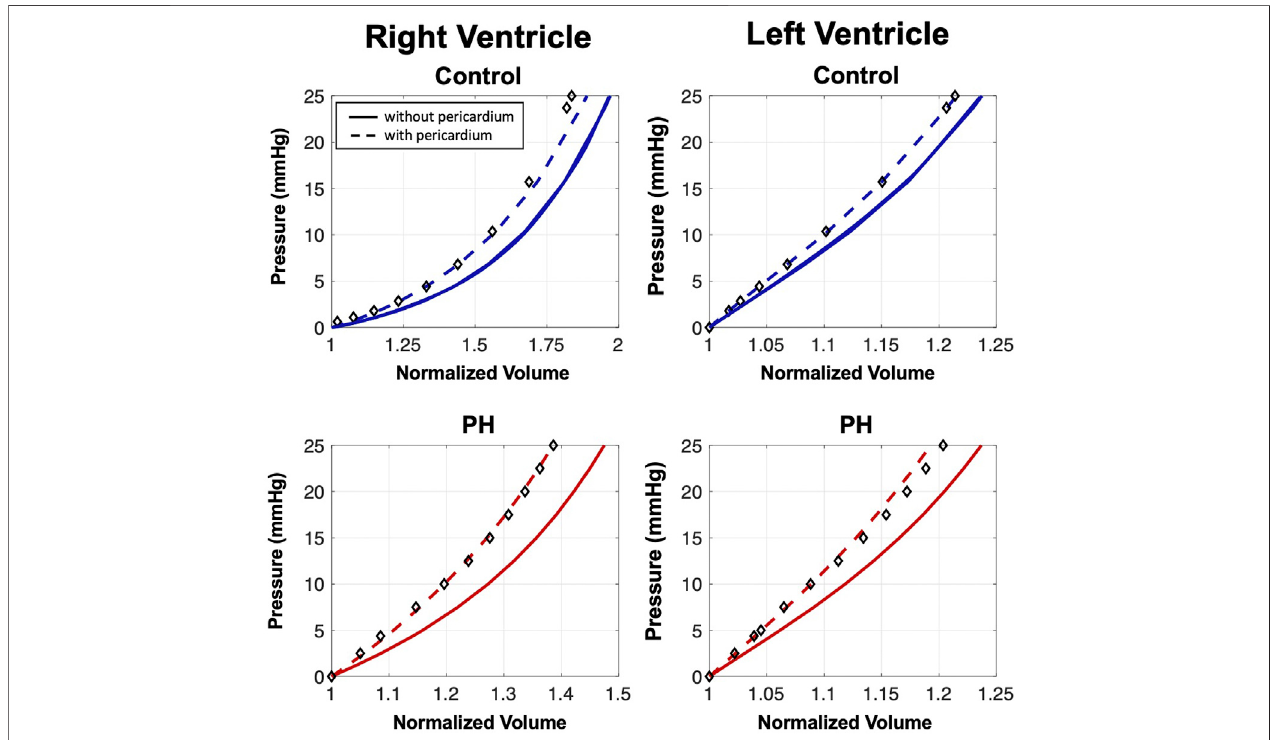
FIGURE2| End-diastolicpressure-volumerelationships(EDPVRs)resultingfromsimultaneouspassiveventricularin fl ation.Curvesdenoteheartmodelpredictions andmarkersindicatetheadjustedexperimental fi ttingdataforthemodelwithpericardium(JanickiandWeber,1980).Additionofthepericardiumresultsinaleftwardshift of the EDPVR. The pericardium has a larger in fl uence on the passive fi lling characteristics of the PH heart.